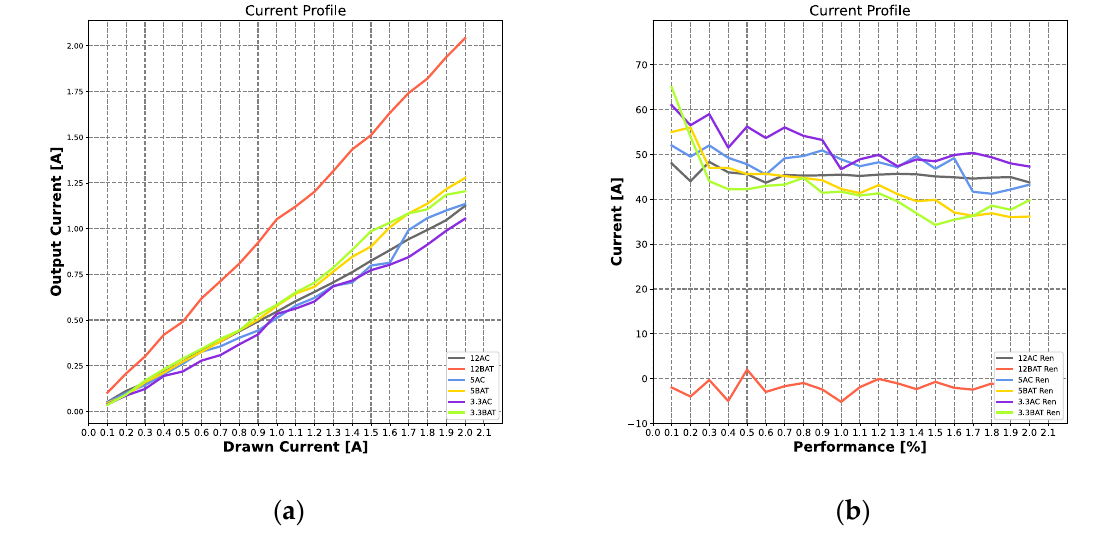
Figure 18. Graphs of ( a ) Current efficiency curve, ( b ) Current efficiency percentage.